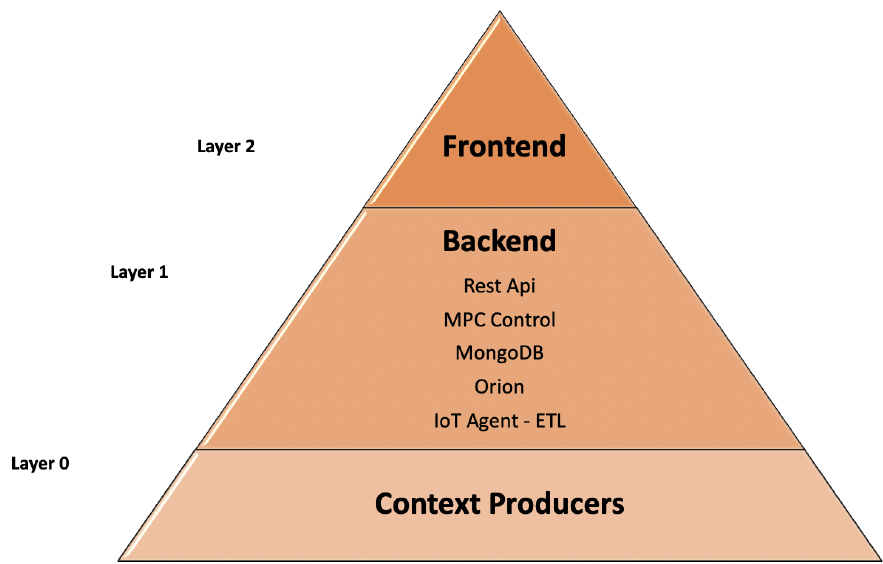
Figure 2. IoT platform as a pyramidal